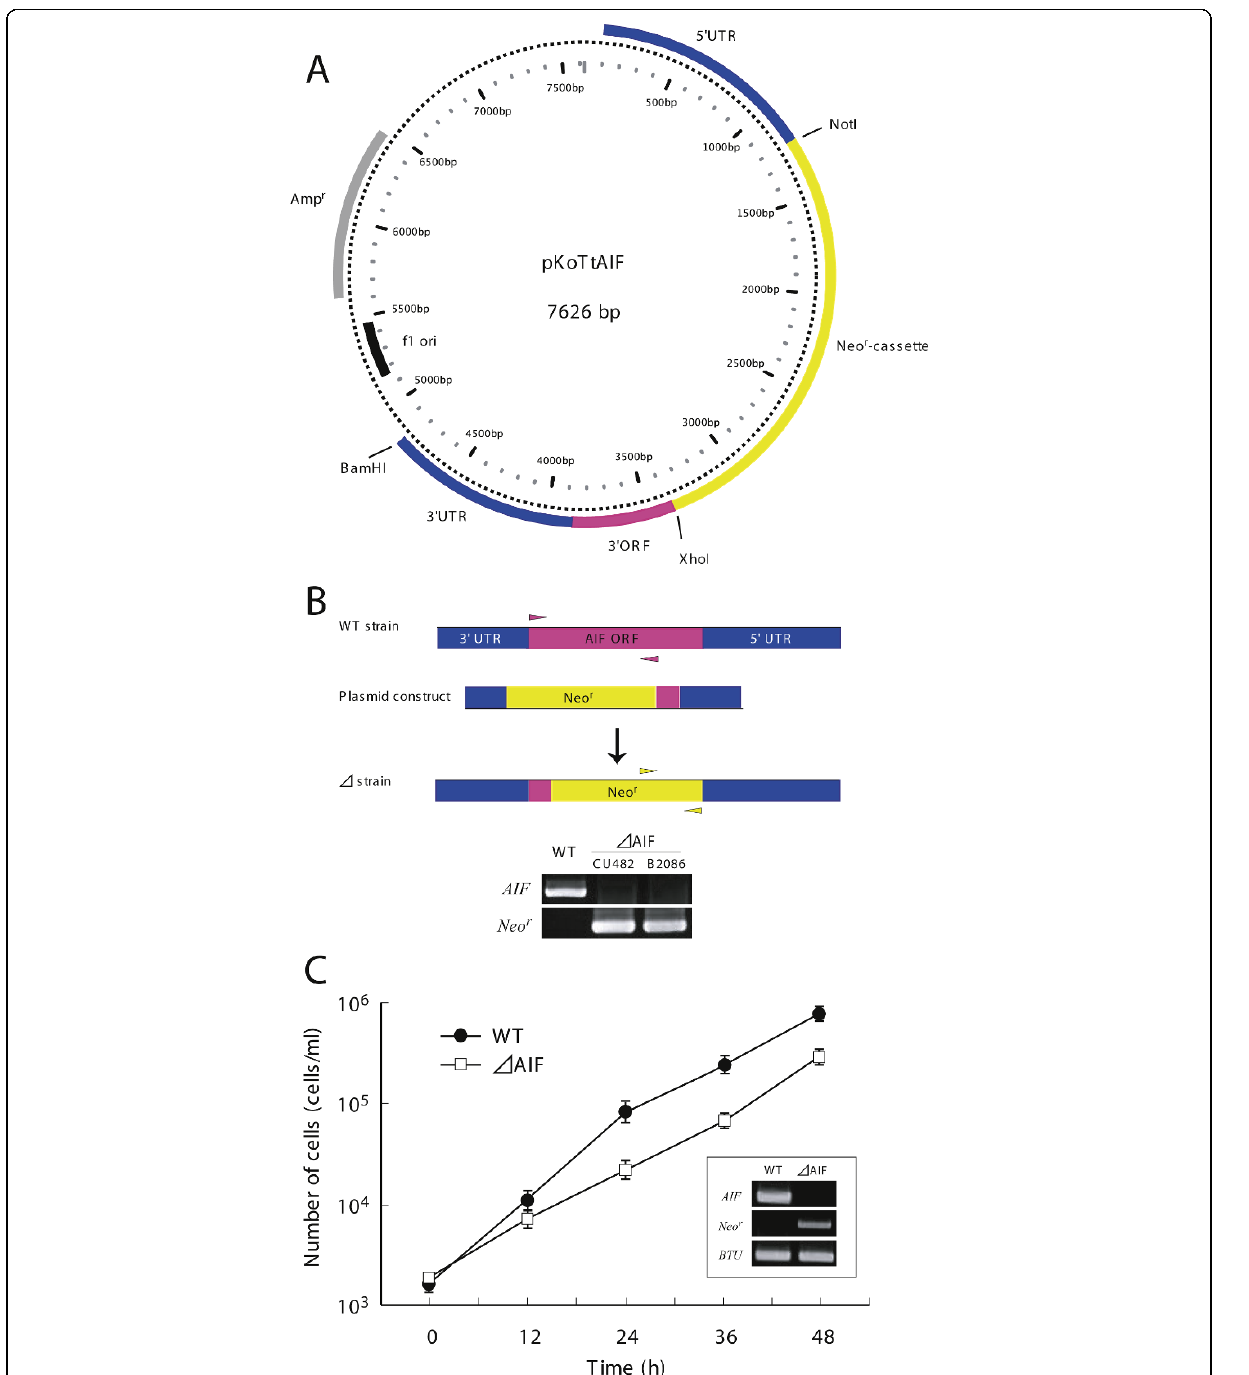
Figure 4 Construction of AIF -deficient strain . A. Map of expression vector, pKoTtAIF, with neomycin resistance cassette (Neo r -cassette). It consists of 5 ’ and 3 ’ UTR sequences of AIF and part of its 3 ’ ORF. The neomycin resistance is expressed under the control of b -tubulin promoter. Before biolistic bombardment, the plasmid was digested with BamHI. B. Schematic representation of the wild-type (WT) and mutant locus of the AIF together with the targeting plasmid. Replacement of AIF to neomycin-resistant gene ( Neo r ) in the macronucleus was confirmed by PCR using 10 ng of genomic DNA from isolated macronuclei as template. Small triangles located in the gene loci indicate specific primer pairs for the PCR amplification. C. Cell growth curve of CU428. Circles and squares indicate cell density of wild-type strain and Δ AIF , respectively. Points and attached bars correspond to the means of four identical measurements and standard deviations. The inset indicates RT-PCR analysis of the expression levels of AIF and Neo r . b -tubulin ( BTU ) was used as a